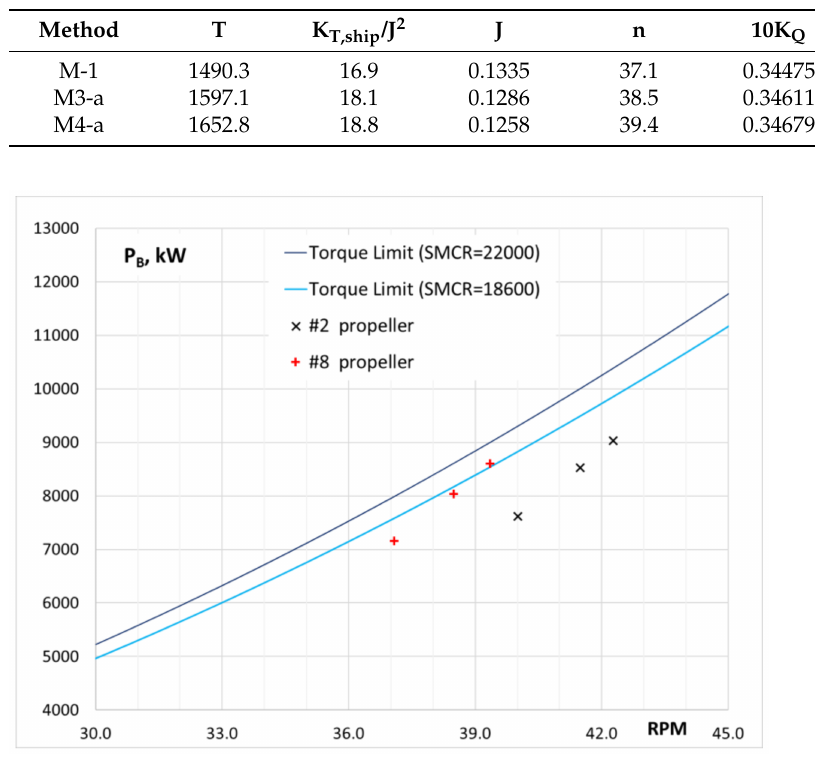
Table 5. Prediction of required propulsion power using #8 propeller.